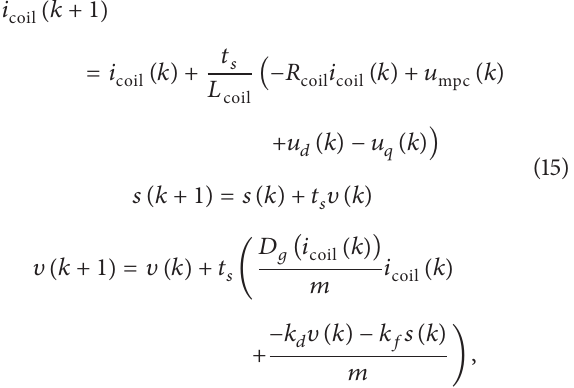
constant voltage source 𝑈 𝑆 (battery). However, to realize a current change as fast as possible to ensure the required dynamic, it is desirable to have a higher voltage applied to the actuator. Therefore, a capacitor 𝐶 , charged with an initial voltage 𝑈 𝑐 higher than the battery level, is used. To maintain the high voltage level of the capacitor during the valve operation, an energy storage block consisting of the capacitor 𝐶 , the diode D5, and the IGBT switch V5 is